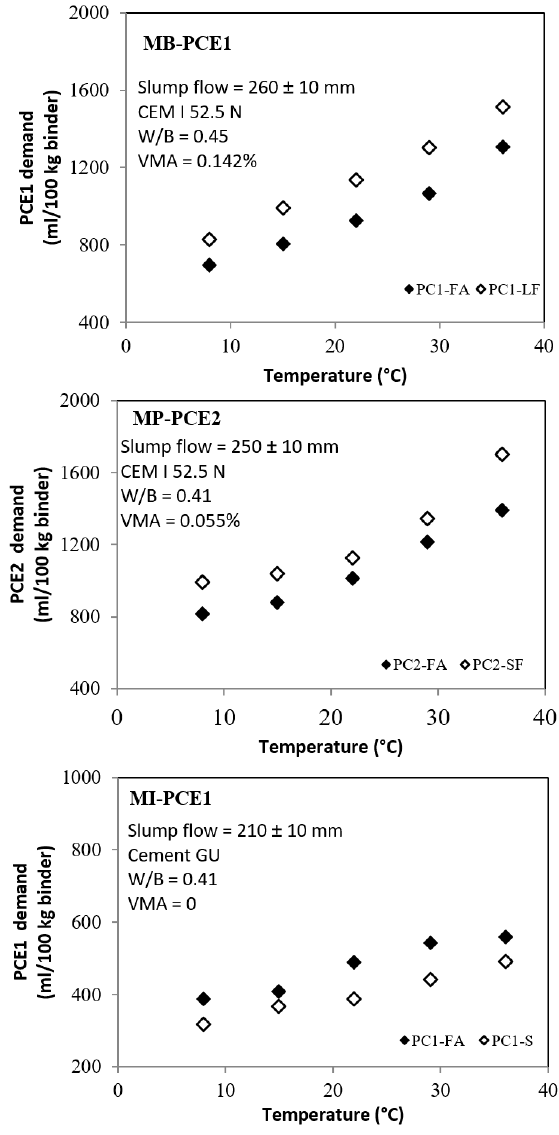
Figure 4. Effect of temperature on PCE demand of CEM